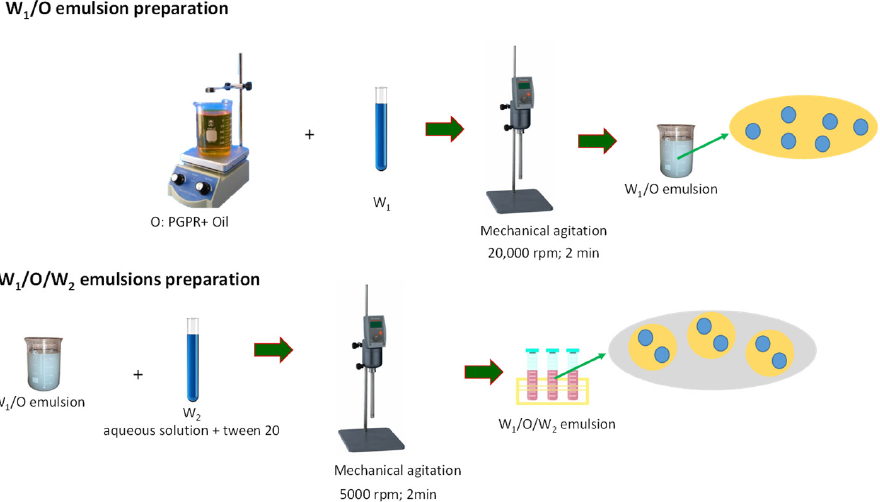
Figure 2. Double emulsion preparation by a two-step emulsification